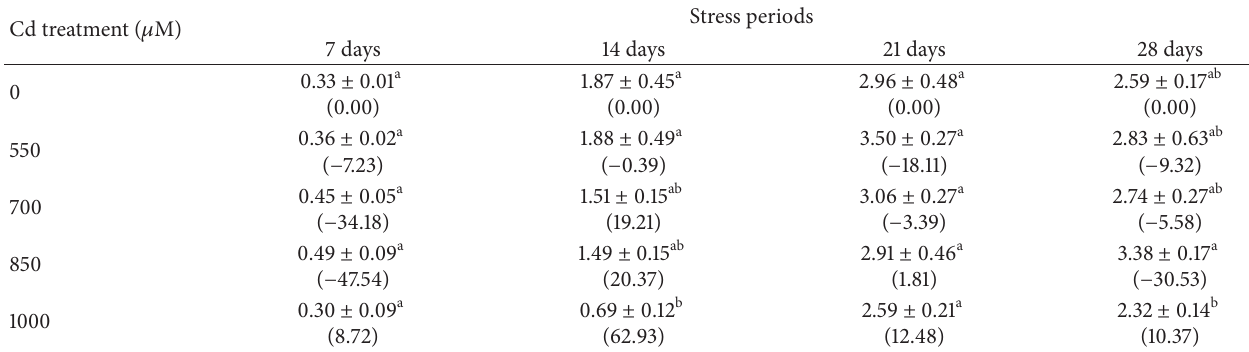
Table 1: Relative fresh weight of cotton callus culture (cv. YZ1) grown under various levels of cadmium. Cd treatment ( 𝜇